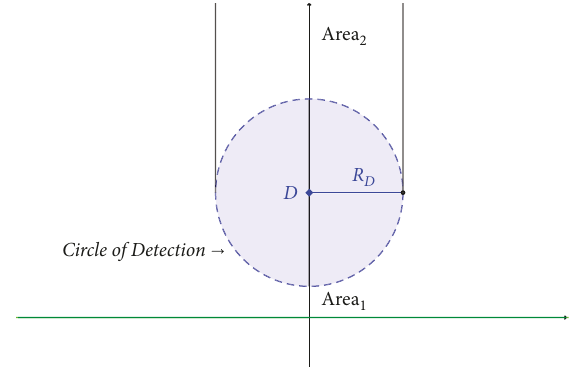
D -based Apollonian P